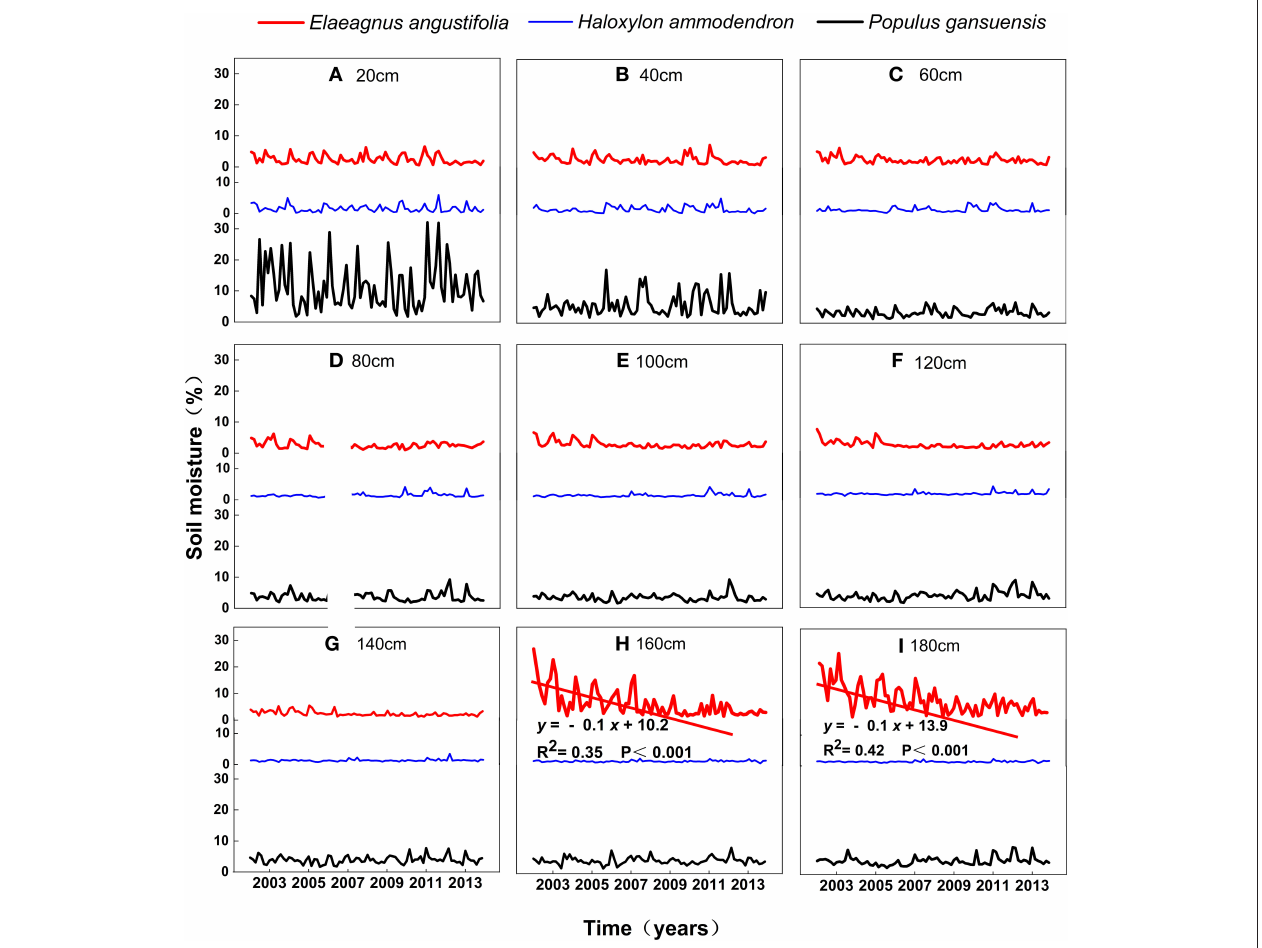
FIGURE 2 | The dynamics of soil water content of different soil layers at (A) 20cm, (B) 40cm, (C) 60cm, (D) 80cm, (E) 100cm, (F) 120cm, (G) 140cm, (H) 160cm, and (I) 180cm in shrubland.